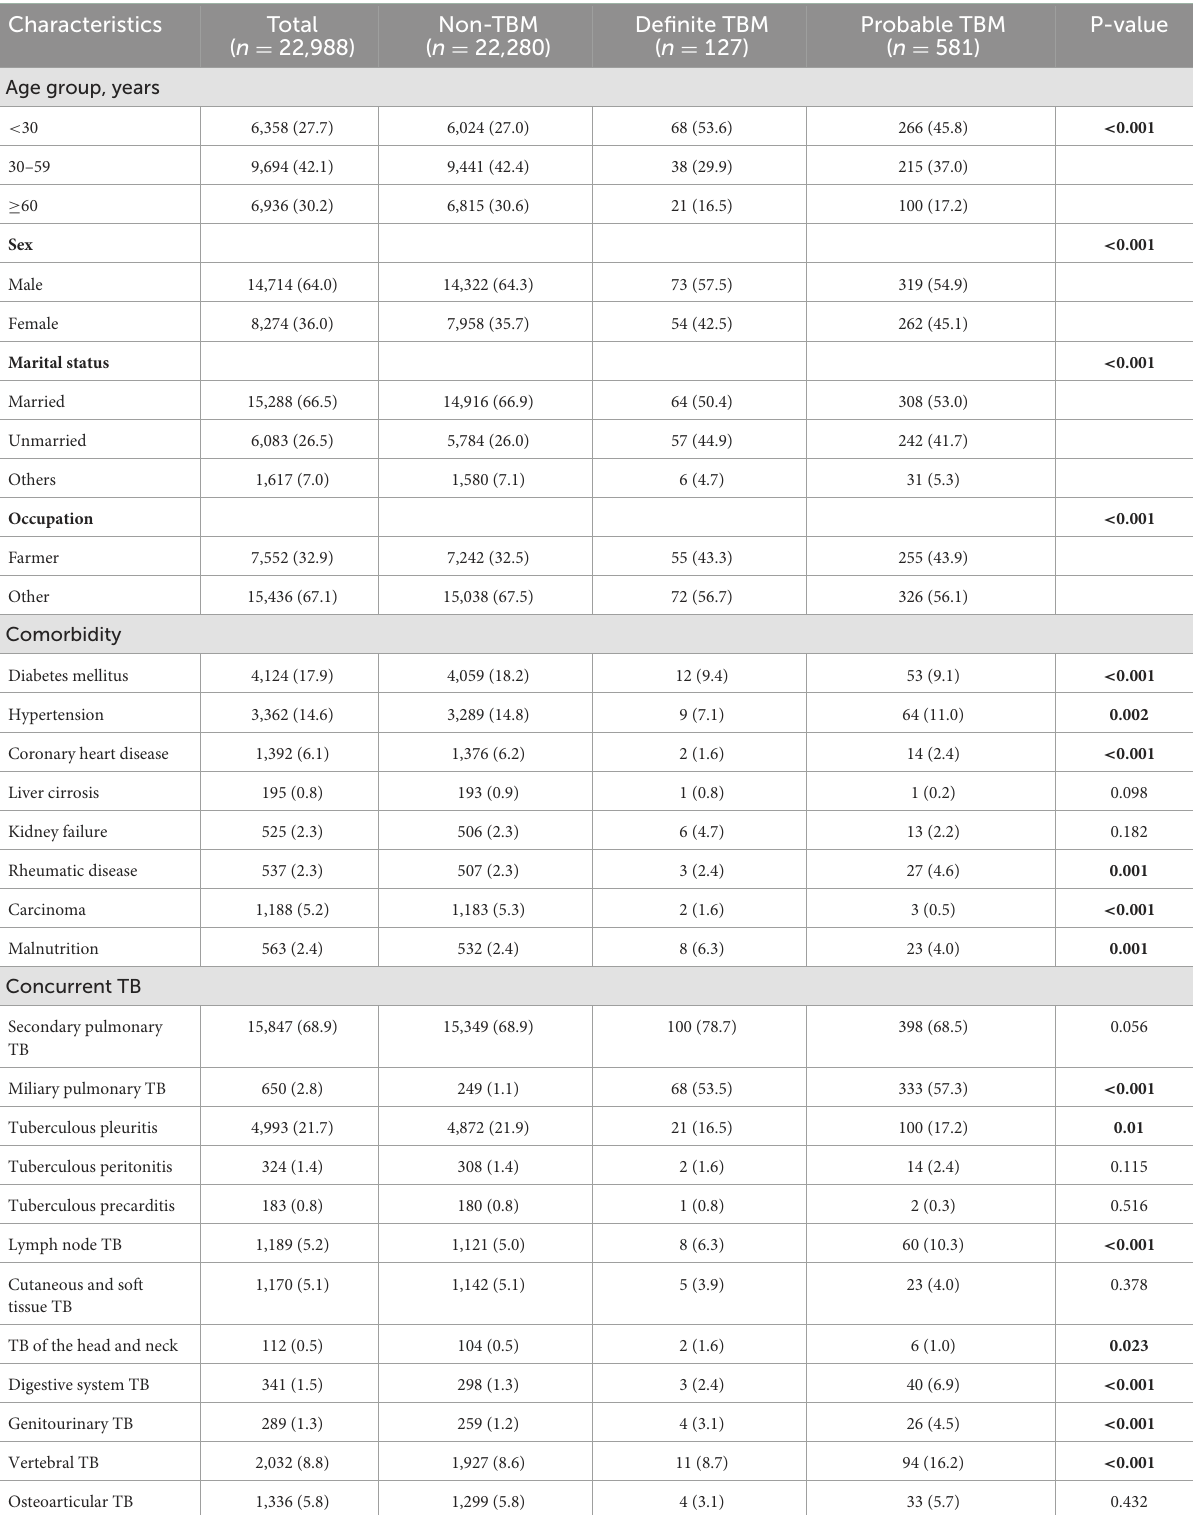
TABLE 1 Demographic and clinical characteristics of 22,988 cases from 2012 to 2019.